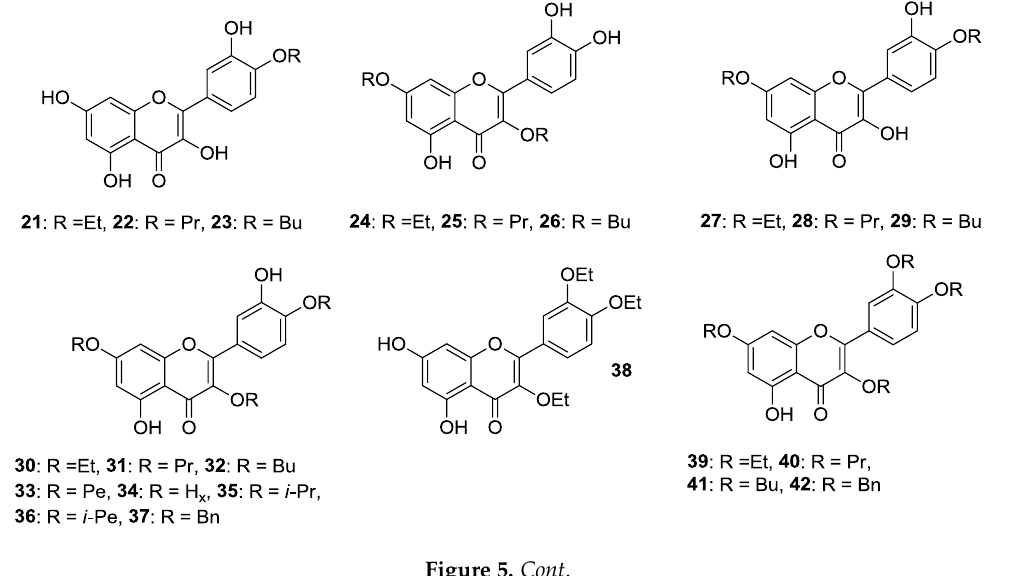
Table 1. Breast cancer resistance protein (BCRP) inhibition by compounds 19 and 20 compared to quercetin 1 .